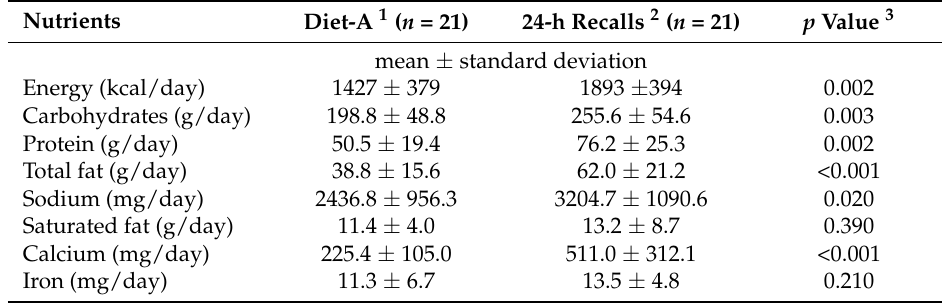
Table 2. Comparison of the nutrient intake from Diet-A vs. nutrient intake from 24-h recalls among all male and female students ( n =